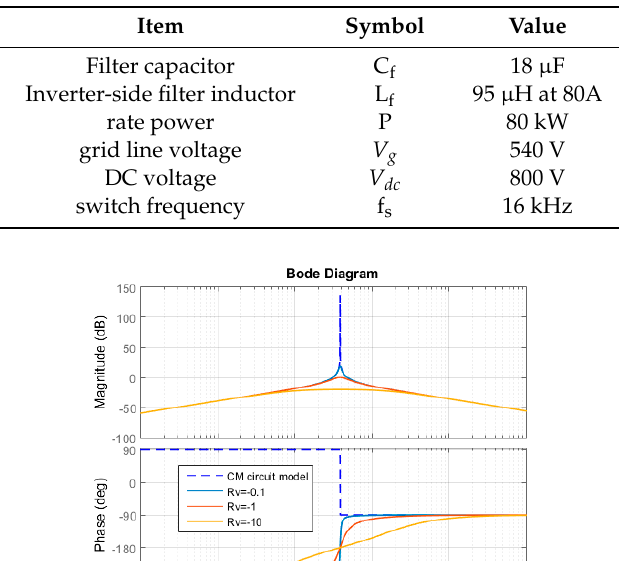
Table 2. Photovoltaic (PV) string inverter parameters.